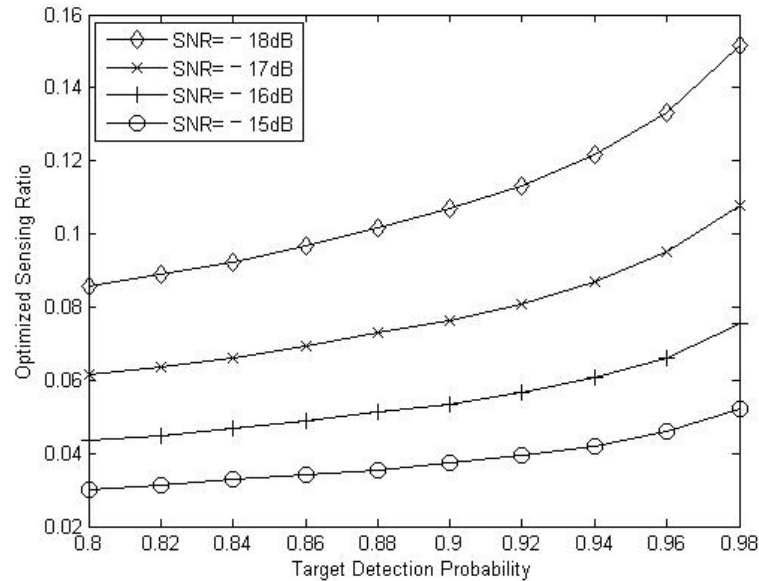
Figure 8. Optimized sensing ratio under target detection.